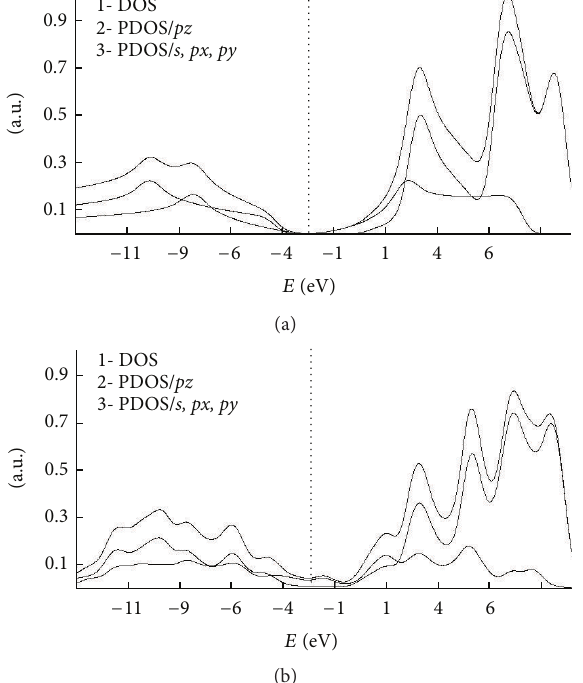
Figure 5: Calculated DOS for (a) silicone sheet and (b) [(5,0),91]- type SWSiNT with splitting on PDOS contributions from 𝜎 and 𝜋 bands. Vertical dotted line indicates Fermi level.